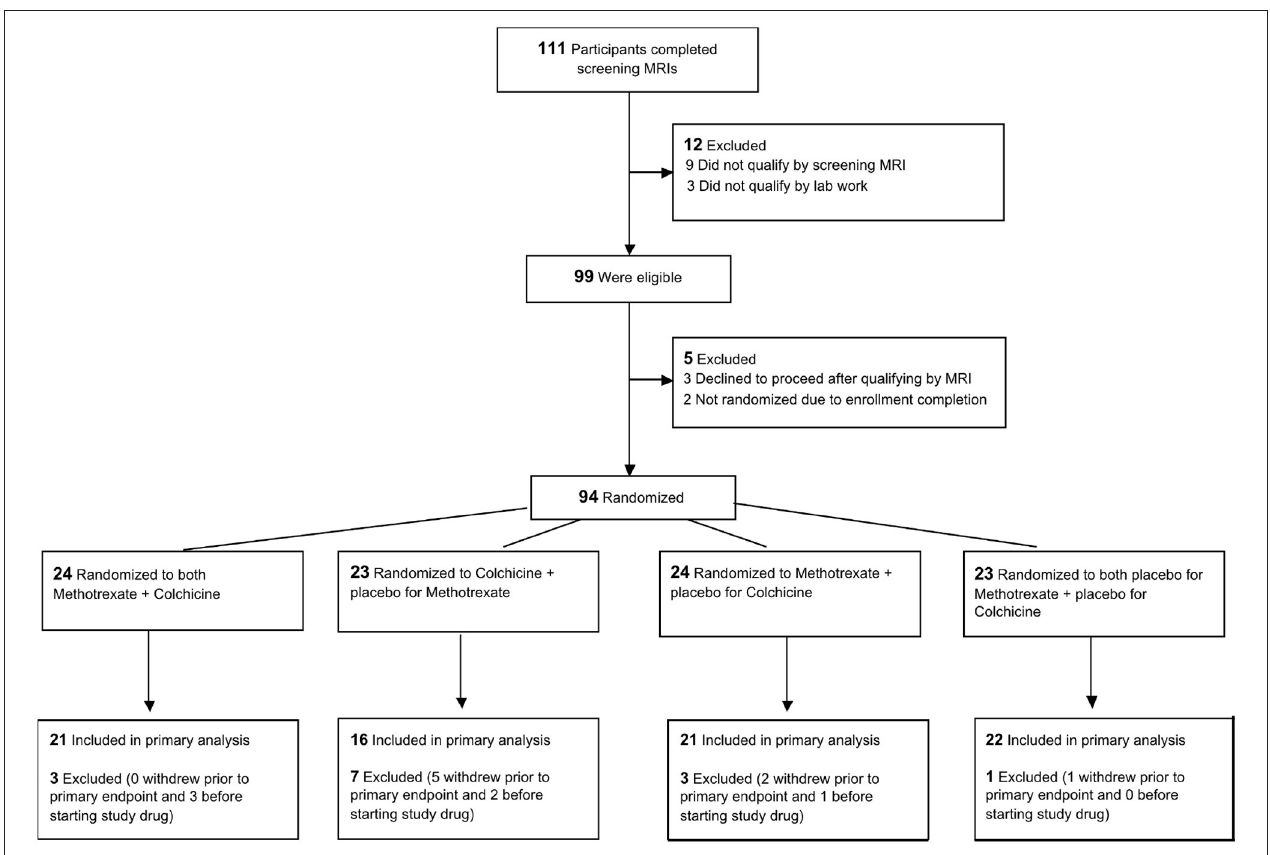
FIGURE 1 | Trial flow